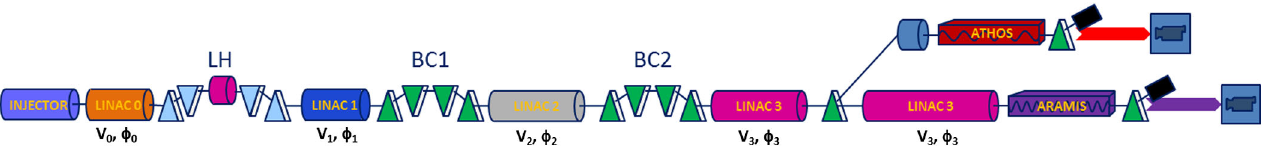
FIG. 1. SwissFEL schematic layout. The symbols for the voltages V in the discussion are also